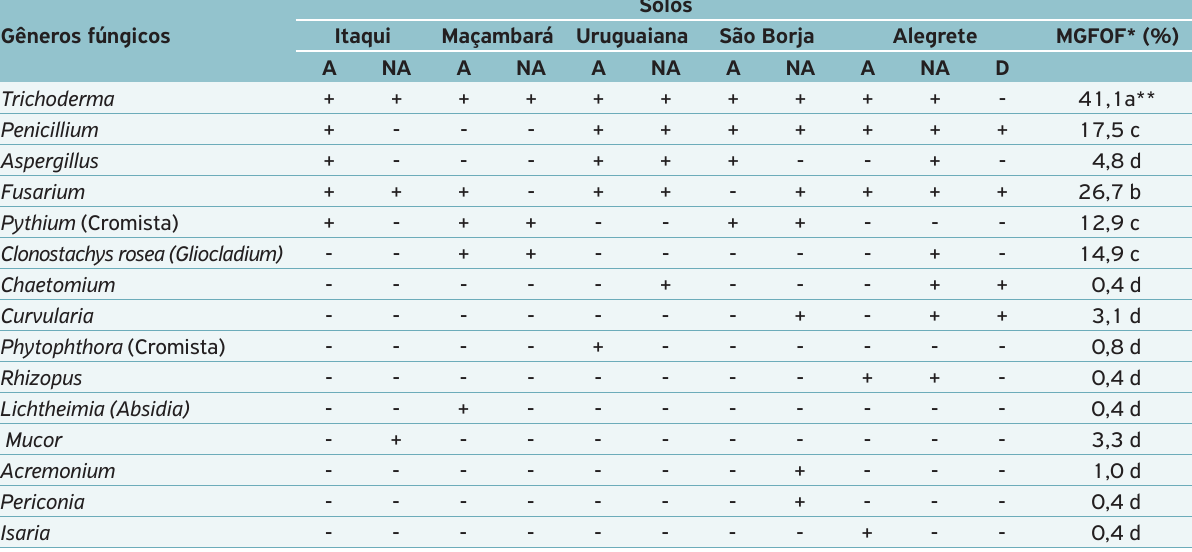
Tabela 2. Presença e média geral de frequência de ocorrência dos fungos (%) parasitários de escleródios de Sclerotinia